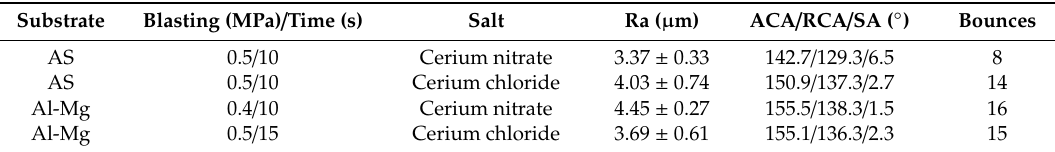
Table 3. Parameters for the most e ffi cient samples used in this study: sandblasting settings, salt used in the immersion, ACA, RCA, SA, average Ra, and number of